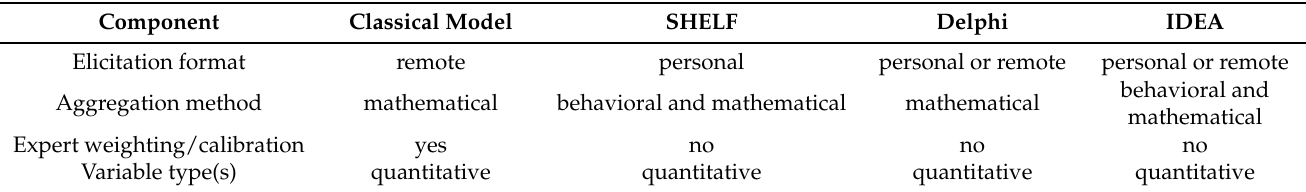
Table 2. Summary of established SEJE